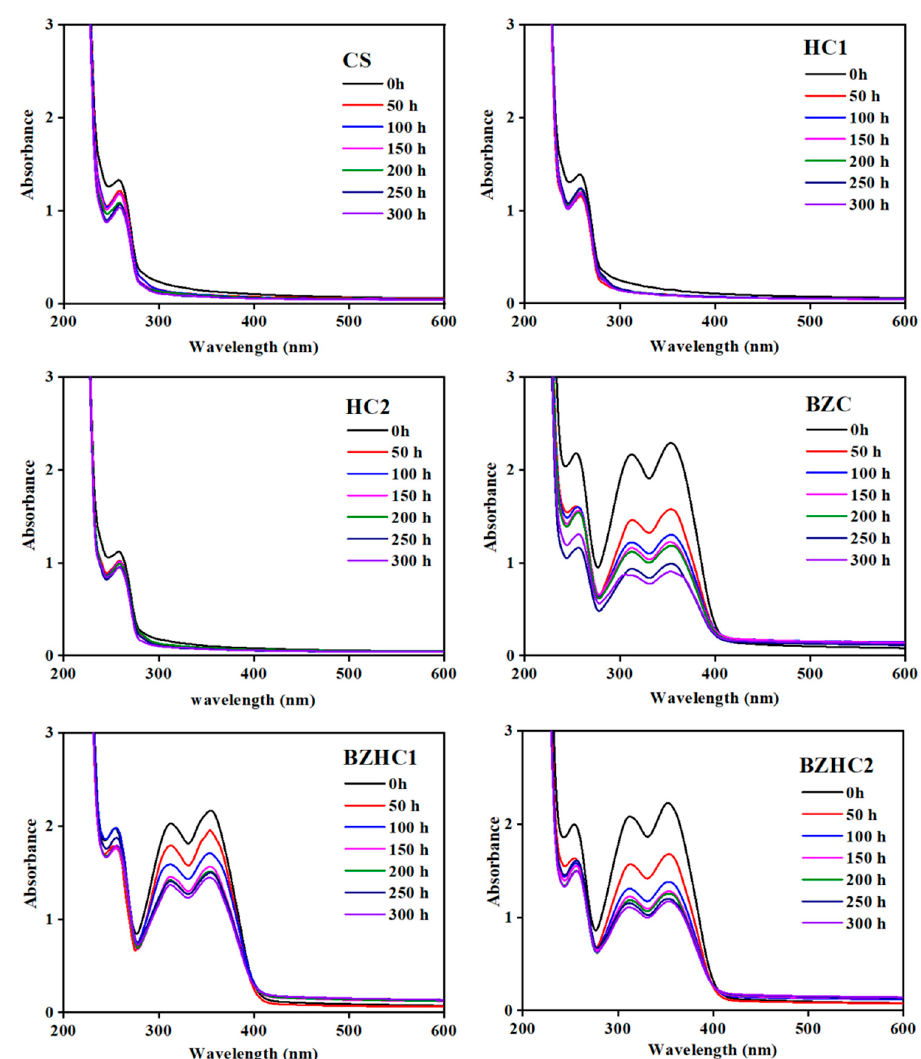
Figure 5. UV-Vis spectrum of free films during weathering.